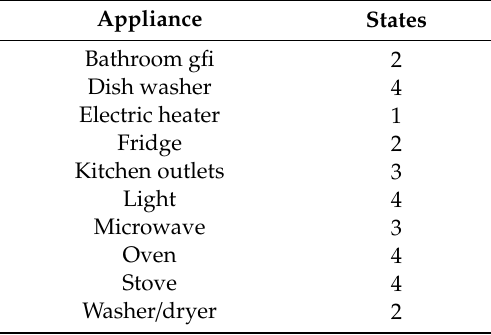
Table 2. Table of different electrical states.